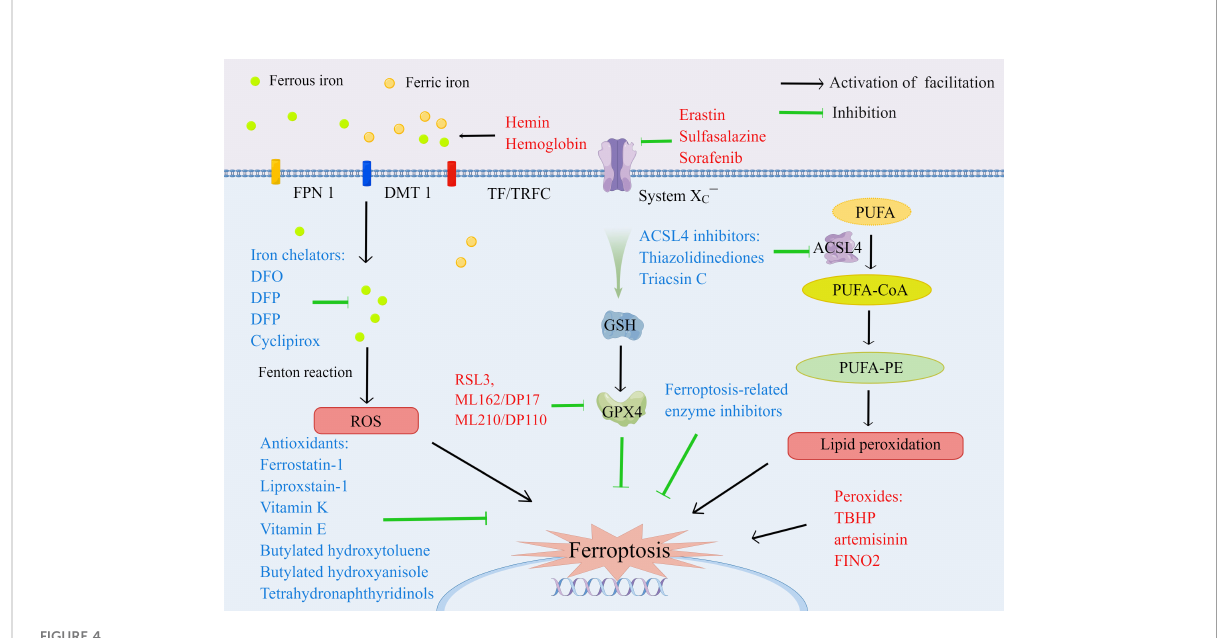
FIGURE 4 The inducers (marked red) and inhibitors (marked blue) of